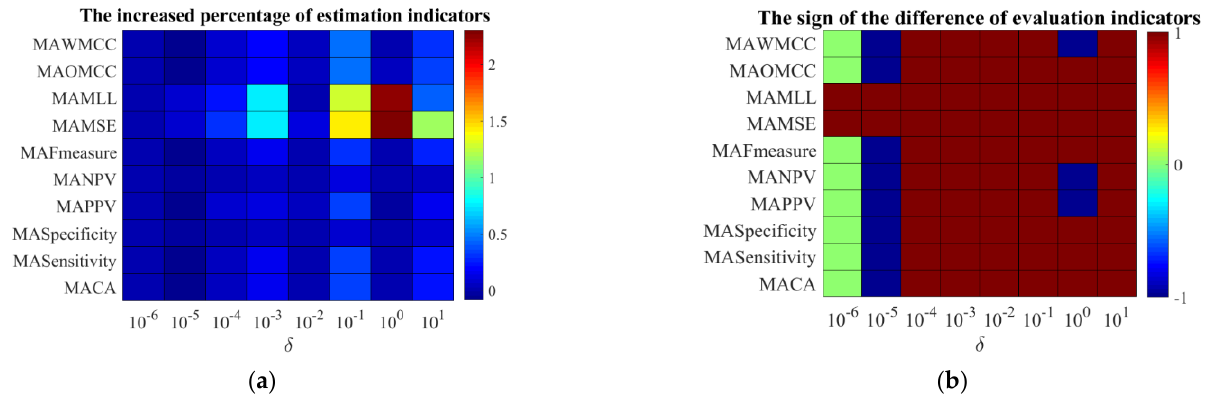
Figure 12. Comparisons between GDCA driven SVM ( α = 0.5) and BDCA driven SVM regarding all the estimation indicators. ( a ) The increased percentage. ( b ) The sign of the difference.